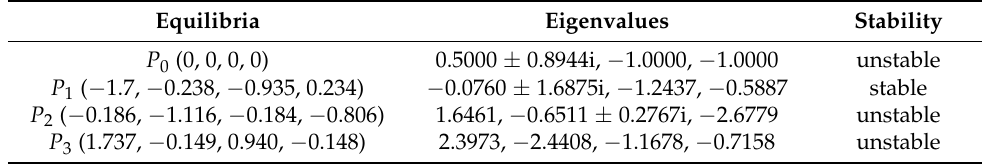
Table 1. Equilibria, eigenvalues and their stability of the HNN.